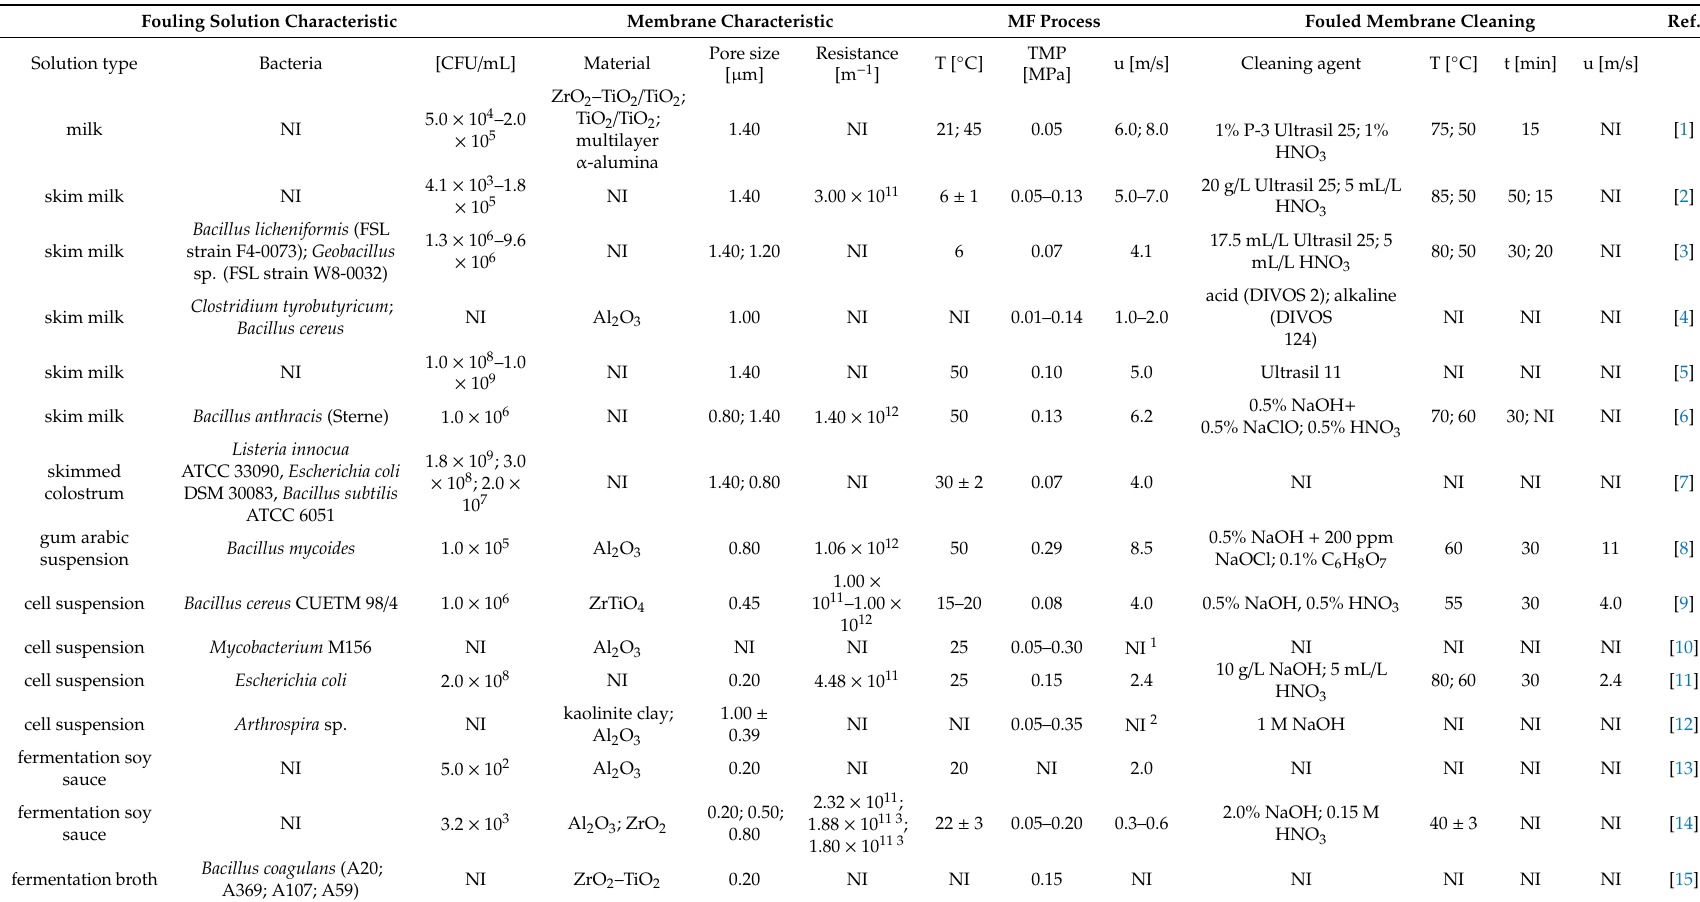
Table A1. Summary of the cross-flow MF of bacterial suspensions by using ceramic membranes: experimental features. Fouling Solution Characteristic Membrane Characteristic MF Process Fouled Membrane Cleaning